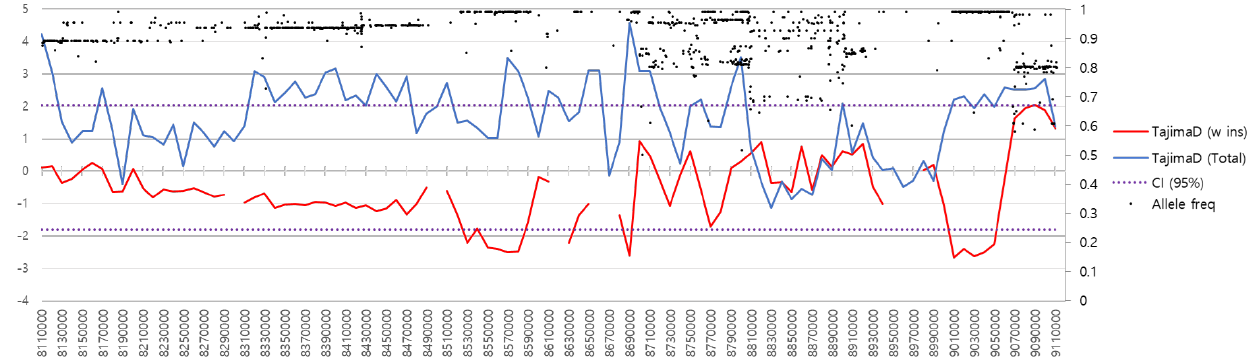
Figure 3. Allele frequency and selection signature for the RSPO2 3' UTR-linked genomic region on CFA 13. The allele frequencies of 1,225 SNPs in the CFA13:8,110,000 − 9,110,000 bp region of 56 RSPO2 3' UTR insertion homozygous dogs are indicated by black dots. Tajima's D is depicted as red and blue lines for 56 dogs homozygous for the RSPO2 3′ UTR inser- tion and 369 dogs consisting of all genotypes. Dotted lines indicate the 95% confidence interval (CI) of Tajima's D value according to the beta distribution corresponding to n =